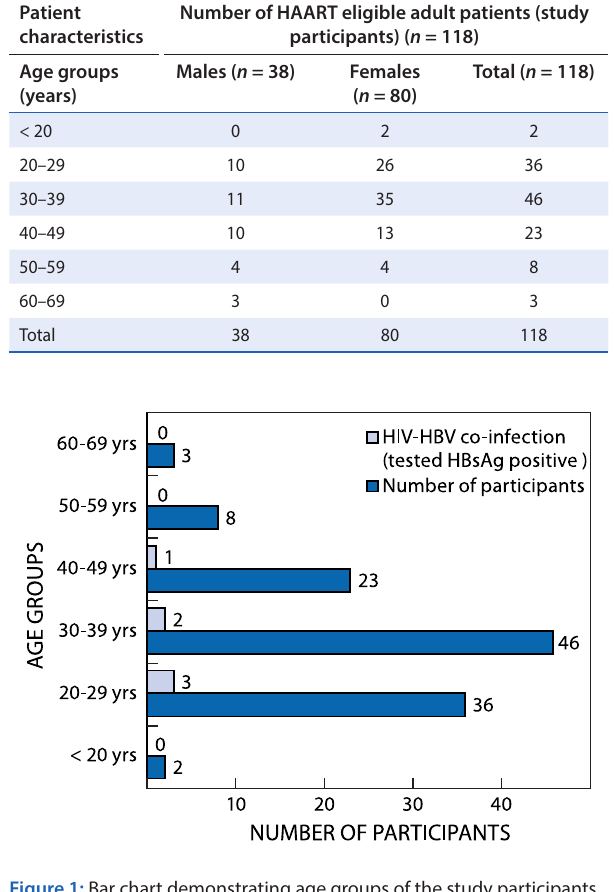
Figure 1: Bar chart demonstrating age groups of the study participants and co-infected participants from the three rural sites, Mahalapye, Ngami and Serowe, Botswana, August to October 2015.